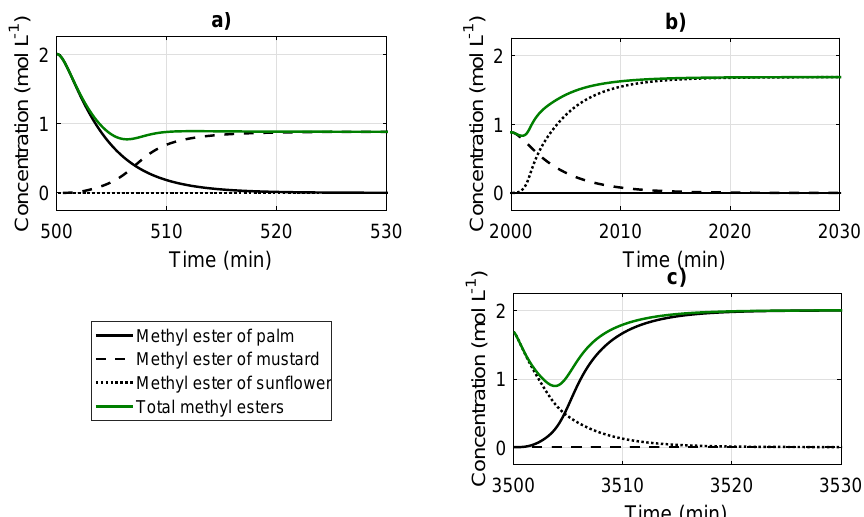
Figure 4. Concentration of methyl esters after changes with different types of feed oil: ( a ) palm to mustard; ( b ) mustard to sunflower; and ( c ) sunflower to